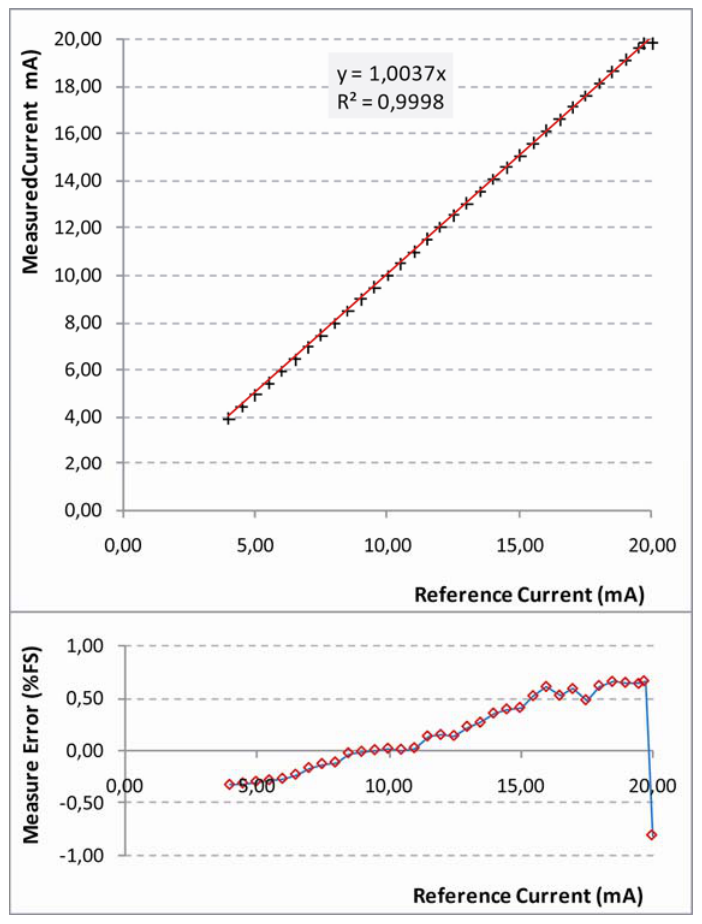
Figure 17. Results of characterization test carried out on UISI Current Output Sensor configuration. Top graph show the measured current vs. the reference current; Bottom graph shows the corresponding error in Full Scale (FS)